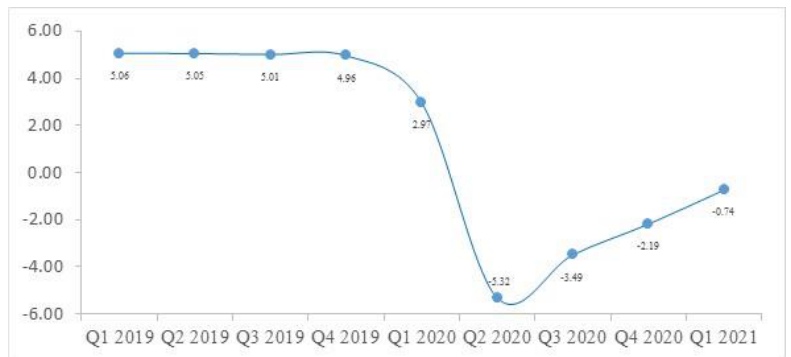
Figure 1. GDP Growth Rate Year 2019-2021 (%) (Source: Statistics Indonesia,